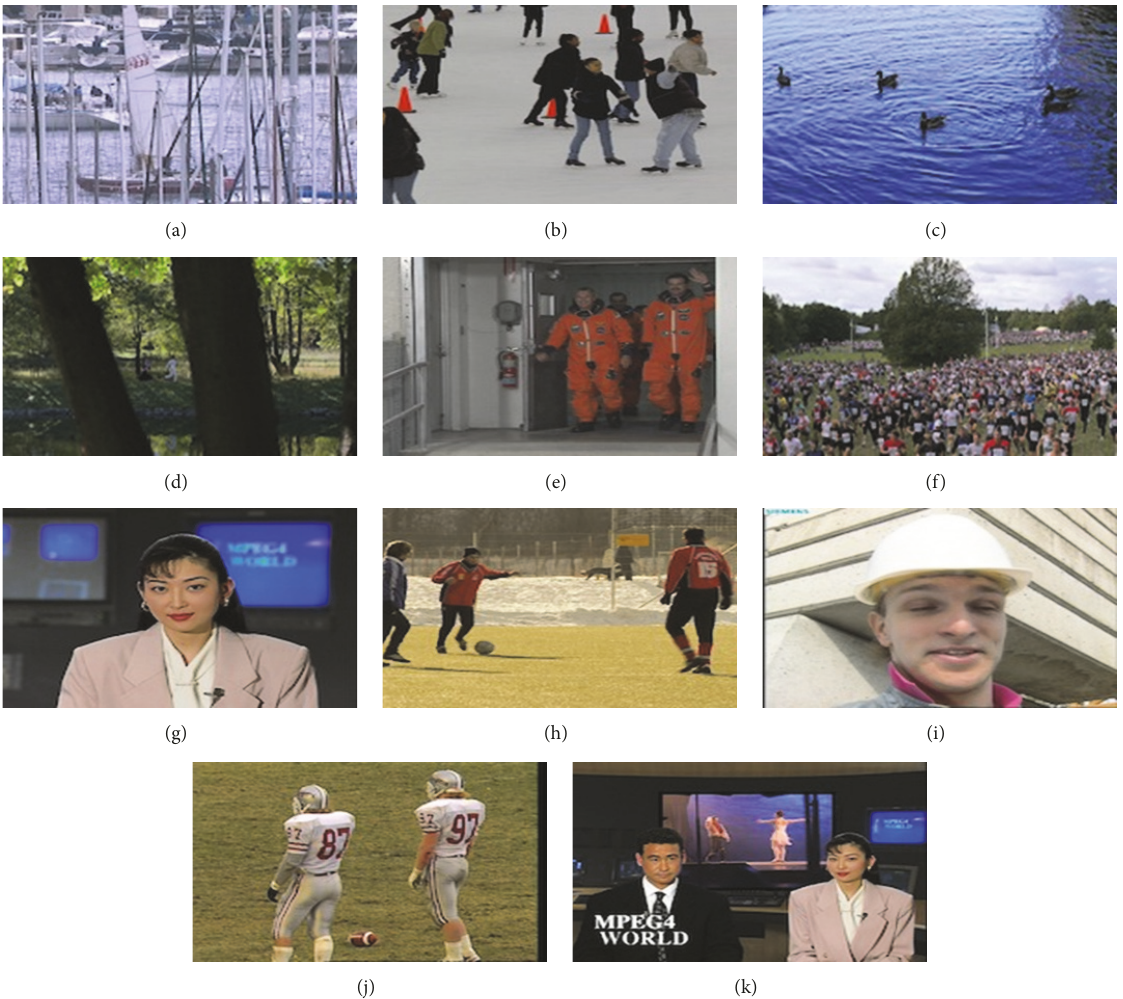
Figure 4: Snapshot of used video sequences: (a) Harbor, (b) Ice, (c) DucksTakeOff, (d) ParkJoy, (e) Crew, (f) CrowdRun, (g) Akiyo, (h) Soccer, (i) Foreman, (j) Football, and (k) News.